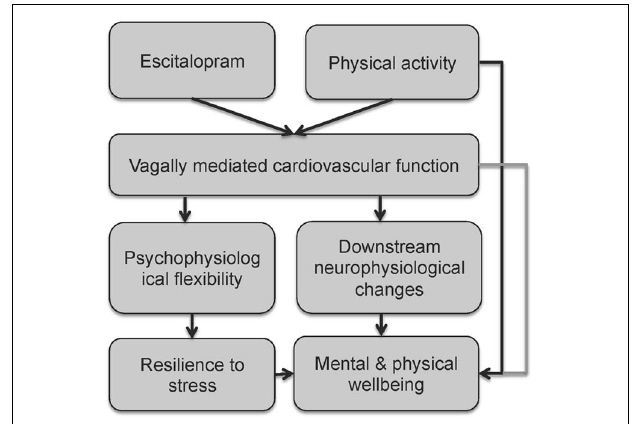
FIGURE 3 | A simplified model for the beneficial effects of regular vigorous physical activity and SSRI treatment on vagal tone, initiating a path towards mental and physical